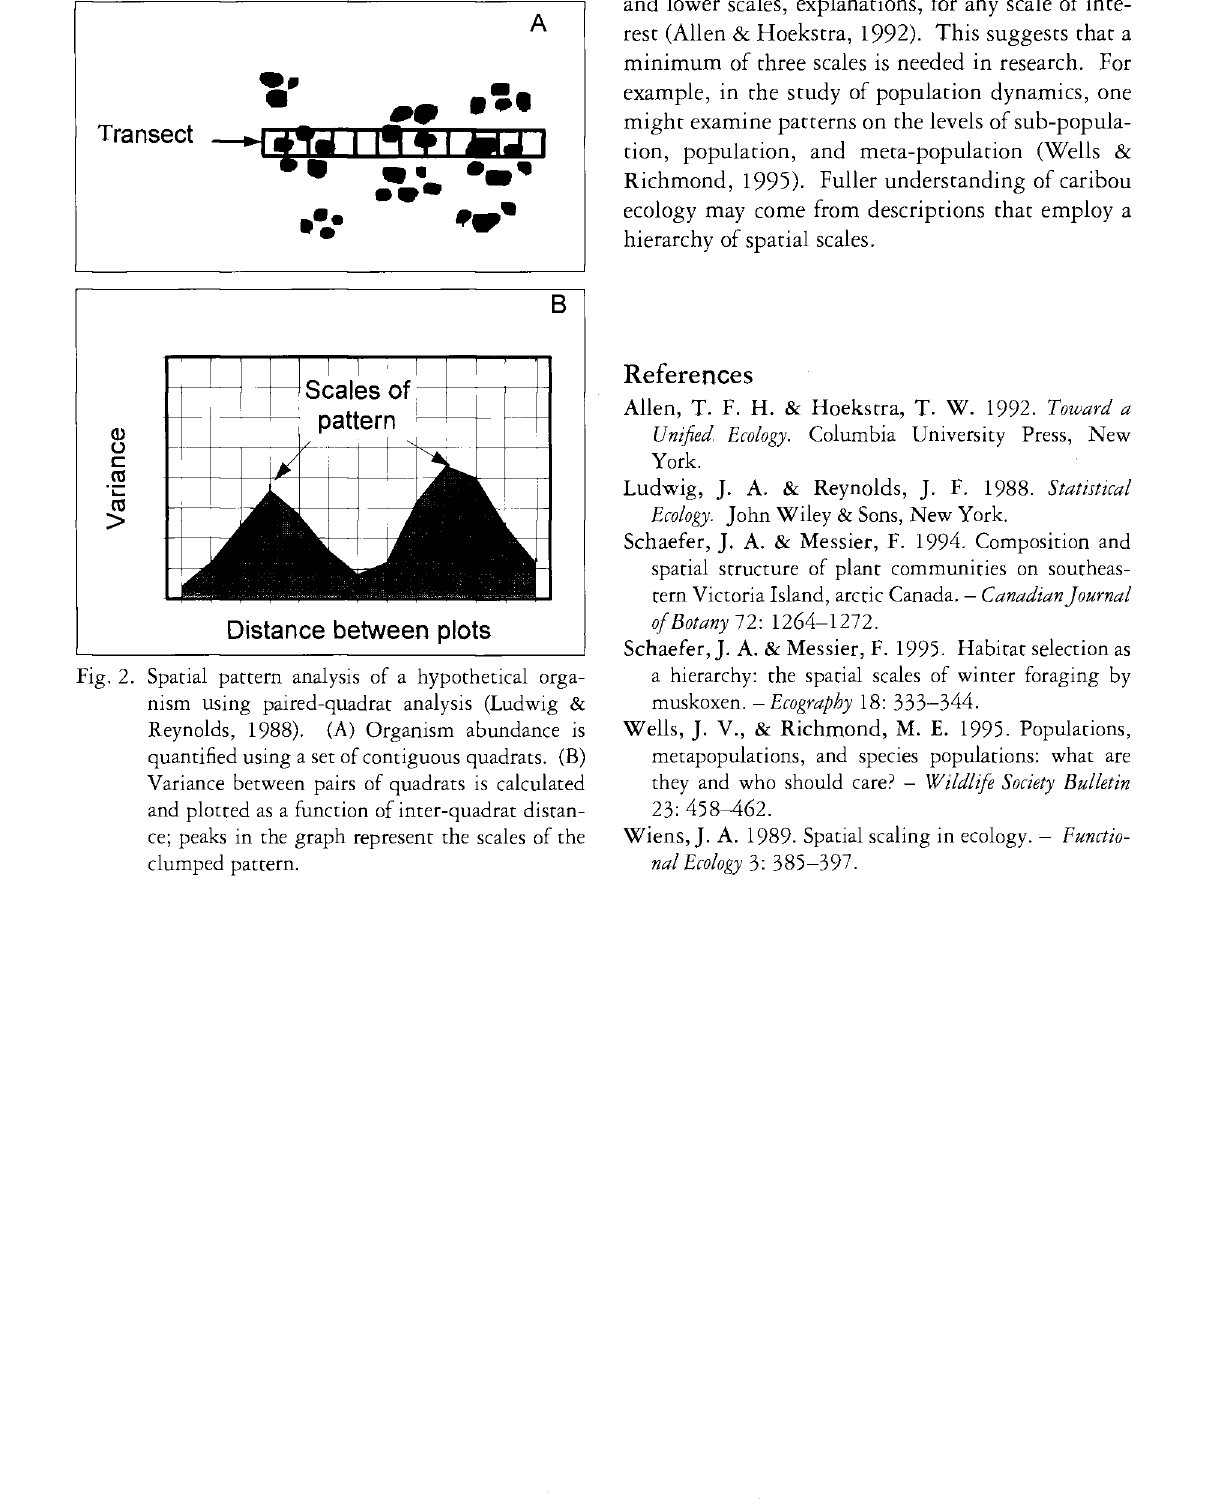
Fig. 2. Spatial pattern analysis of a hypothetical orga nism using paired-quadrat analysis (Ludwig & Reynolds, 1988). (A) Organism abundance is quantified using a set of contiguous quadrats. (B) Variance between pairs of quadrats is calculated and plotted as a function of inter-quadrat distan ce; peaks in the graph represent the scales of the clumped